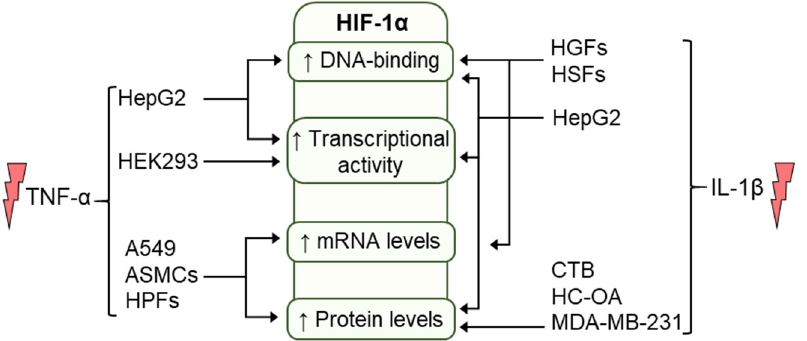
Figure 3. Effects of TNF- α and IL-1 β stimulation on HIF-1 α DNA-binding, transcriptional activity, mRNA, and protein levels in different cell types.